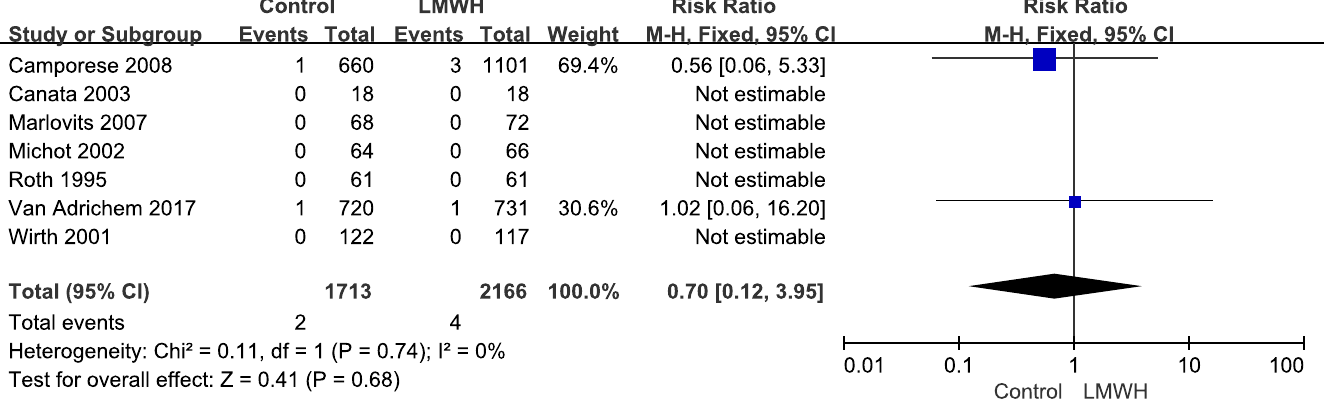
Fig 7. LMWH versus control. Major bleeding during follow-up.